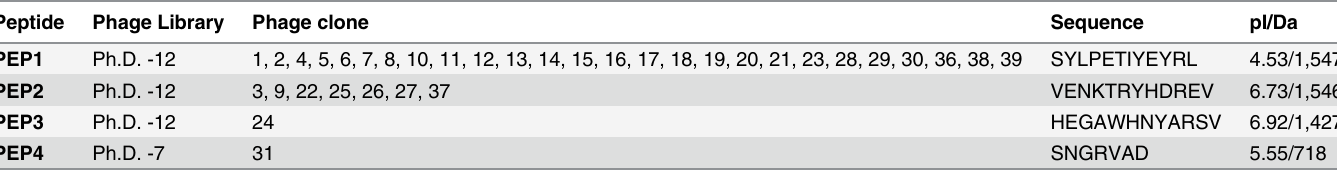
Table 2. Four classes of the phage displayed peptides that interact with FvTox1.